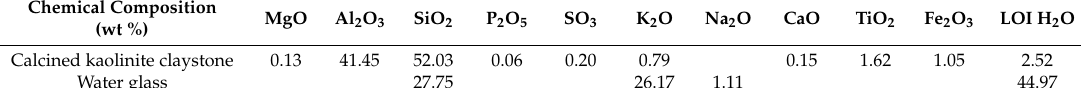
Table 1. Chemical composition of the calcined kaolinite claystone (wt %) and potassium water glass DVS1.7.